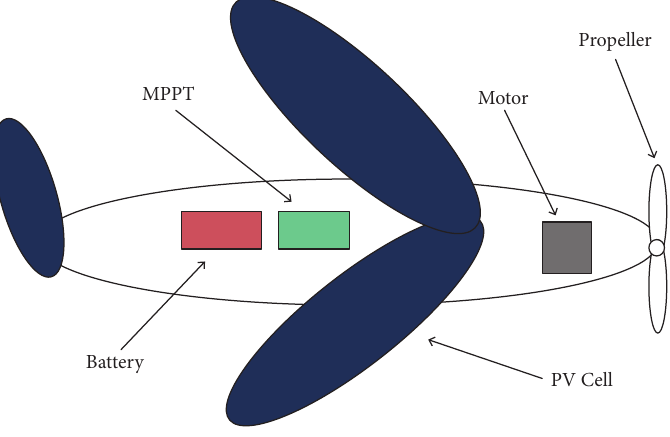
Figure 1. The power device of solar-powered aircraft (Gao et al. 2015).